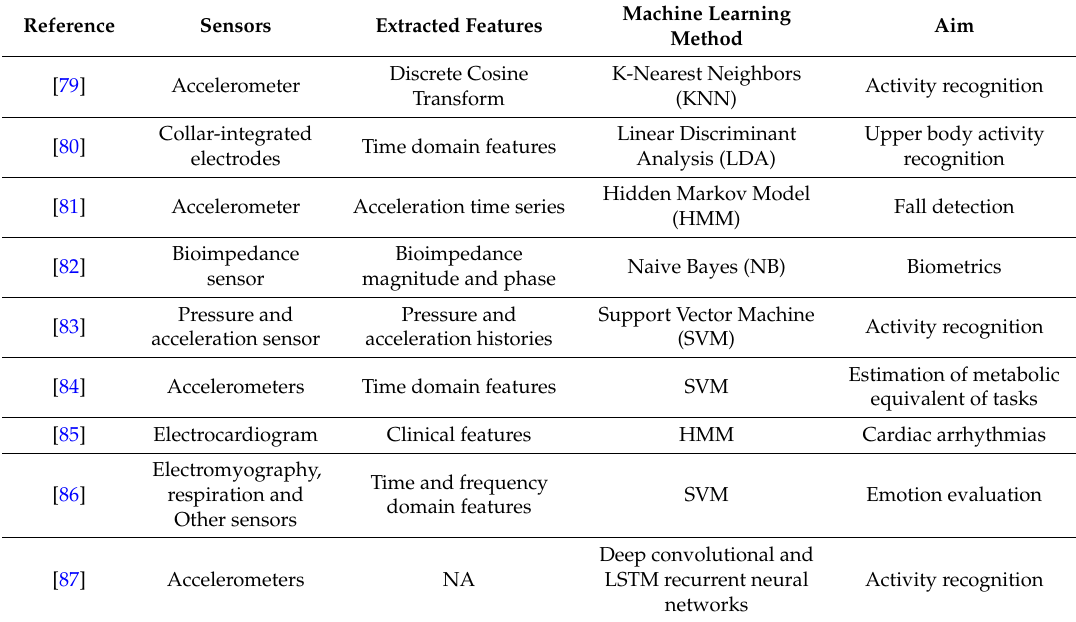
Table 2. Some existing wearable sensor systems and their related machine learning techniques and